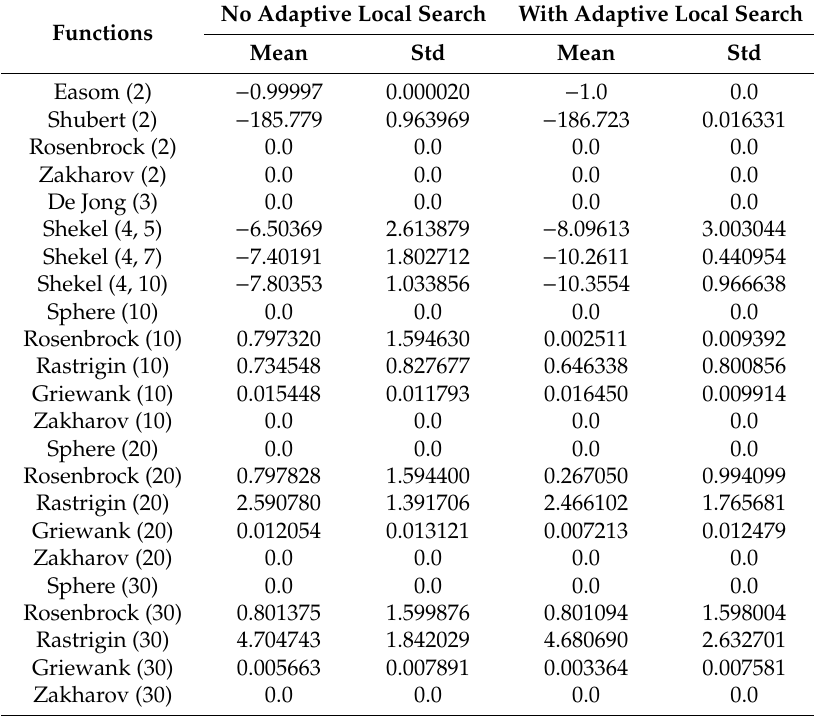
Table 4. The mean best function value and the standard deviation obtained by CFA with or without adaptive local